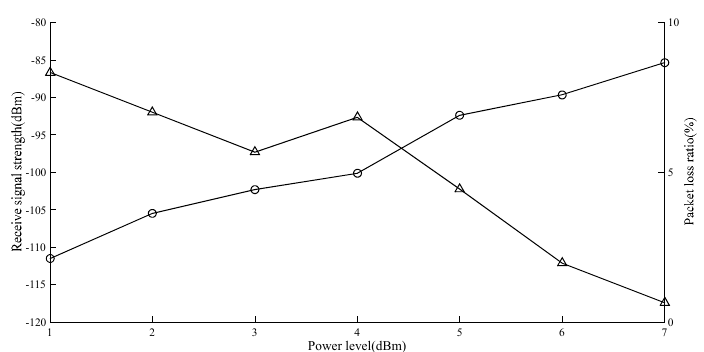
Figure 13. Influence of different transmitting power on link quality.